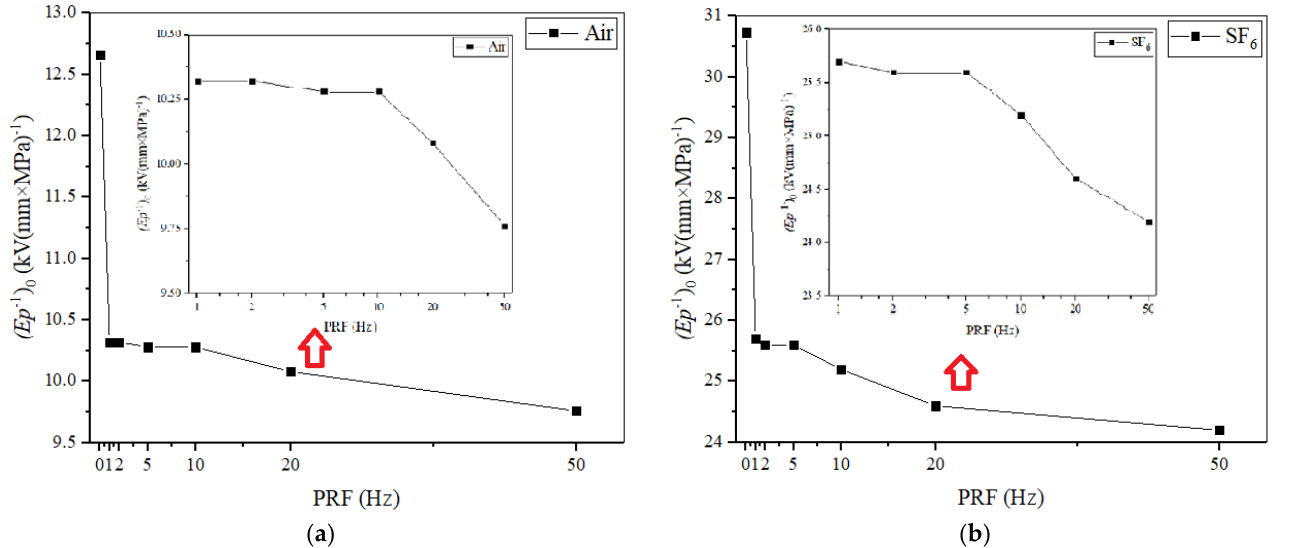
Figure 20. ( E / p ) 0 varies with PRF in ( a ) air and ( b ) SF 6